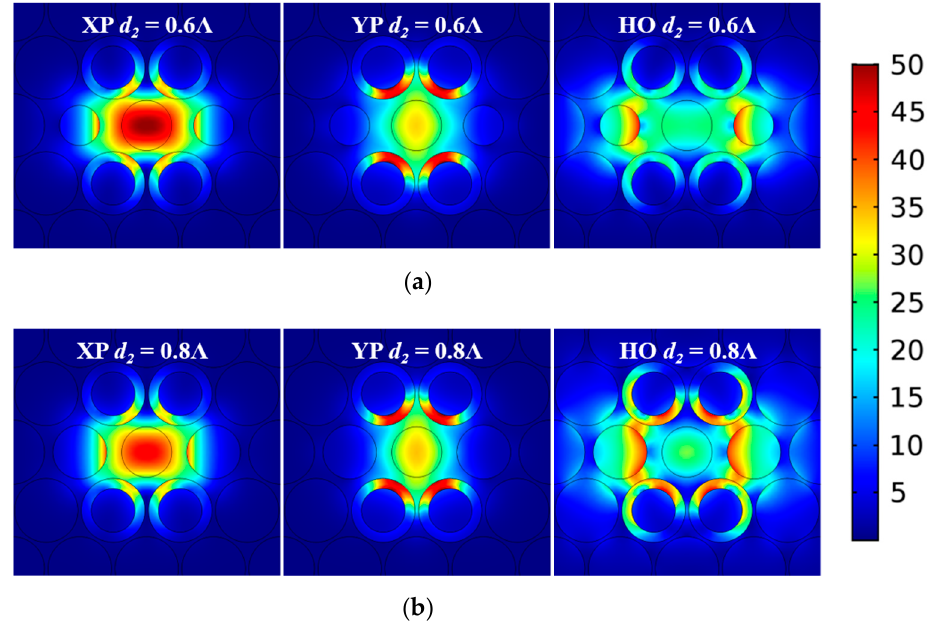
Figure 8. Simulated distributions of the magnitude of the total electric field of the XP, YP, and HO modes of the active ENZ-based PCF at 1.0 THz when ( a ) d 2 = 0.6 Λ and ( b ) d 2 = 0.8 Λ . (The scale bar is the same for all subplots.)